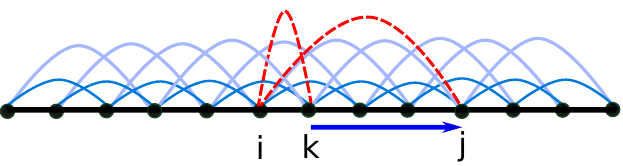
Figure 11 . The range of the preformed bi-local (cid:12)elds (denoted as solid lines) determines the range of hopping for a local perturbation added to the system (denoted as dashed lines). For example, a local disturbance (cid:14)T ik can hop to (cid:14)T ij via the bonds that are formed between sites k and j . the leading order in Q , (cid:14)T ( t ) ; (cid:14)P ( t ) ij ij